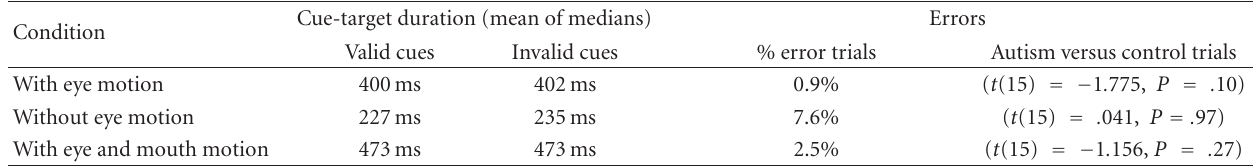
Table 2: Data on the experimenter’s cue durations: cue-target durations, proportions of trials with errors, and t -tests for di ff erences in mean cue-target duration for each group.